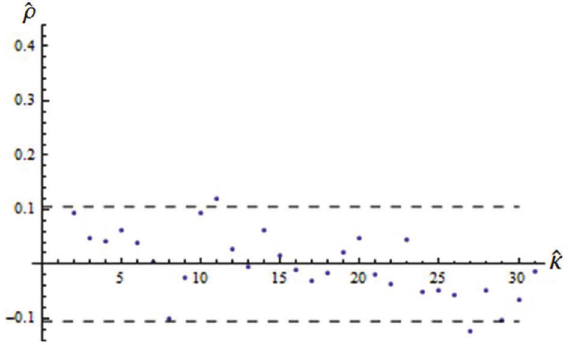
Figure 3. Representative illustration of cross-correlation of the residues for the standard diet